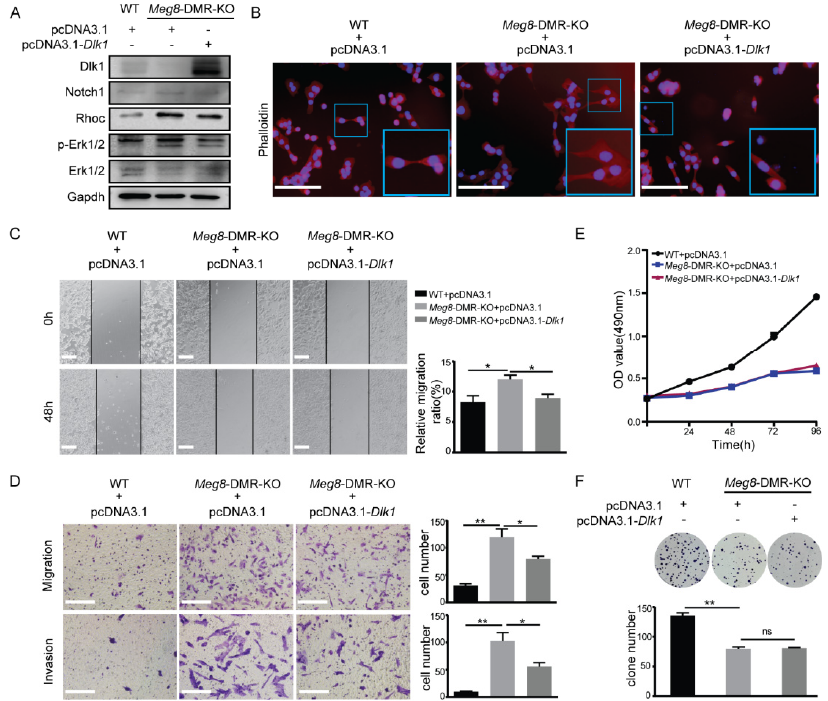
Figure 6. Overexpression of Dlk1 in Meg8 − DMR − KO suppressed cells’ migration and invasion by blocking Notch1 − Rhoc − MAPK/ERK. ( A ) Western blot shows the expression level of Dlk1 was re- duced while Nocth1 Rhoc and p-ERK1/2 were activated in Meg8 -DMR-KO. When the overexpres- sion vector pcDNA3.1- Dlk1 was transfected into Meg8 -DMR-KO, the expression of Nocth1, Rhoc, and p-ERK1/2 was reduced. ( B ) Immunofluorescence staining of Phalloidin-California Red Con- jugate in WT, Meg8 -DMR-KO, and Meg8 -DMR-KO with Dlk1 overexpression. ( C ) Confluent mon- olayers of cells of WT, Meg8 -DMR-KO and Meg8 -DMR-KO with Dlk1 overexpression were wounded and after being incubated for an additional 48 h, the relative migration ratio was calcu- lated. ( D ) Migration and invasion of WT, Meg8 -DMR-KO, and Meg8 -DMR-KO with Dlk1 overex- pression were analyzed. ( E ) Cell proliferation of WT, Meg8 -DMR-KO and Meg8 -DMR-KO with Dlk1 overexpression was measured via MTT assay. ( F ) Colonies grown from cells of WT, Meg8 -DMR-KO, and Meg8-DMR-KO with Dlk1 overexpression were counted. Error bars, mean ± SEM. n ≥ 3. p values were calculated using t -test. * p < 0.05, ** p < 0.01, ns (non-significant), scale bars = 200 μ m. We also used MTT and colony formation assays to determine whether Dlk1 over- expression had any influence on cell proliferation, and the results demonstrate that it had no effect in Meg8 -DMR-KO (Figure 6E, F). 2.5. Absence of Meg8-DMR Has No Impact on the Methylation of Other DMRs in the Dlk1-Dio3 Domain Including the IG-DMR, which serves as the imprinting control region, there are three known paternally methylated DMRs which can regulate the expression of imprinted genes in the Dlk1-Dio3 domain [30]. We employed bisulfite sequencing to examine DNA methylation in WT, Meg8 -DMR-KO, CTCFBS-KO, and (GGCG)n-KO cell lines to deter- mine whether the deletion of the Meg8 -DMR can affect the methylation status of these three DMRs. The results showed that the Dlk1 -DMR and IG-DMR were hypermethylated in the WT MLTC-1 cell line, but the Gtl2 -DMR was hypomethylated in one half and hyper- methylated in the other half (Figure 7A). The methylation status of these three DMRs in